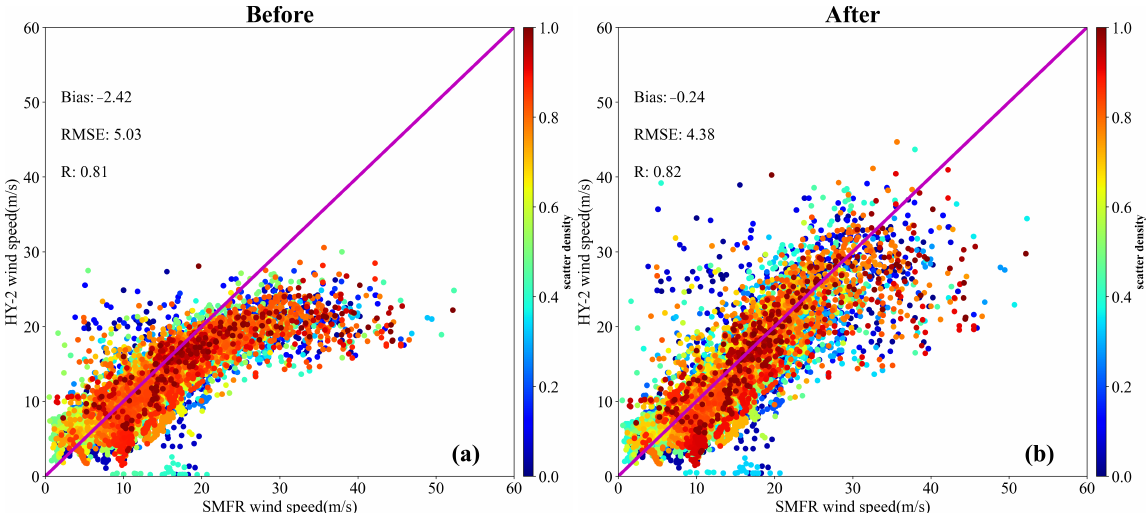
Figure 11. Statistical analysis ( a ) before and ( b ) after revision by the BP-NN algorithm under rainfall conditions.